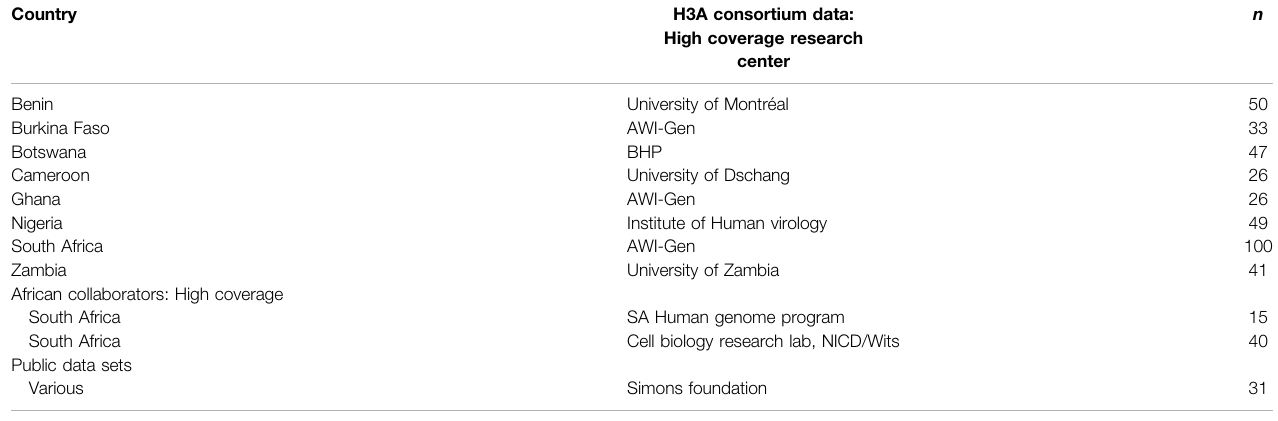
TABLE 1 | Sources of high-coverage data sets used to form HAAD: 272 genomes were generated by a supplementary grant from the NIH to the H3A Consortium (Choudhury et al., 2020) for the primary purpose ofdesigning a custom genotypingarray; 100were produced byAWI-Gen; 40 were shared by African collaborators; 15 genomes came from the Southern African Human Genome Program (SAHGP), and 31 genomes were from the Simons Foundation Genome Diversity Project. Country